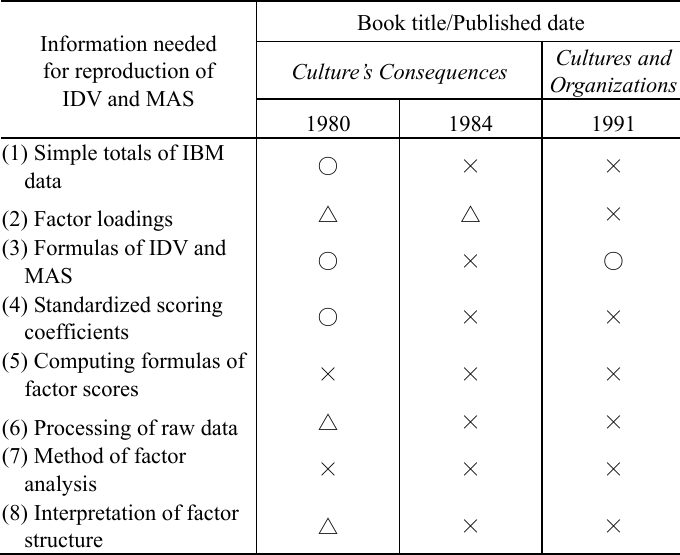
Table 1. The State of Disclosures on Processing and Statistical Analysis of IBM